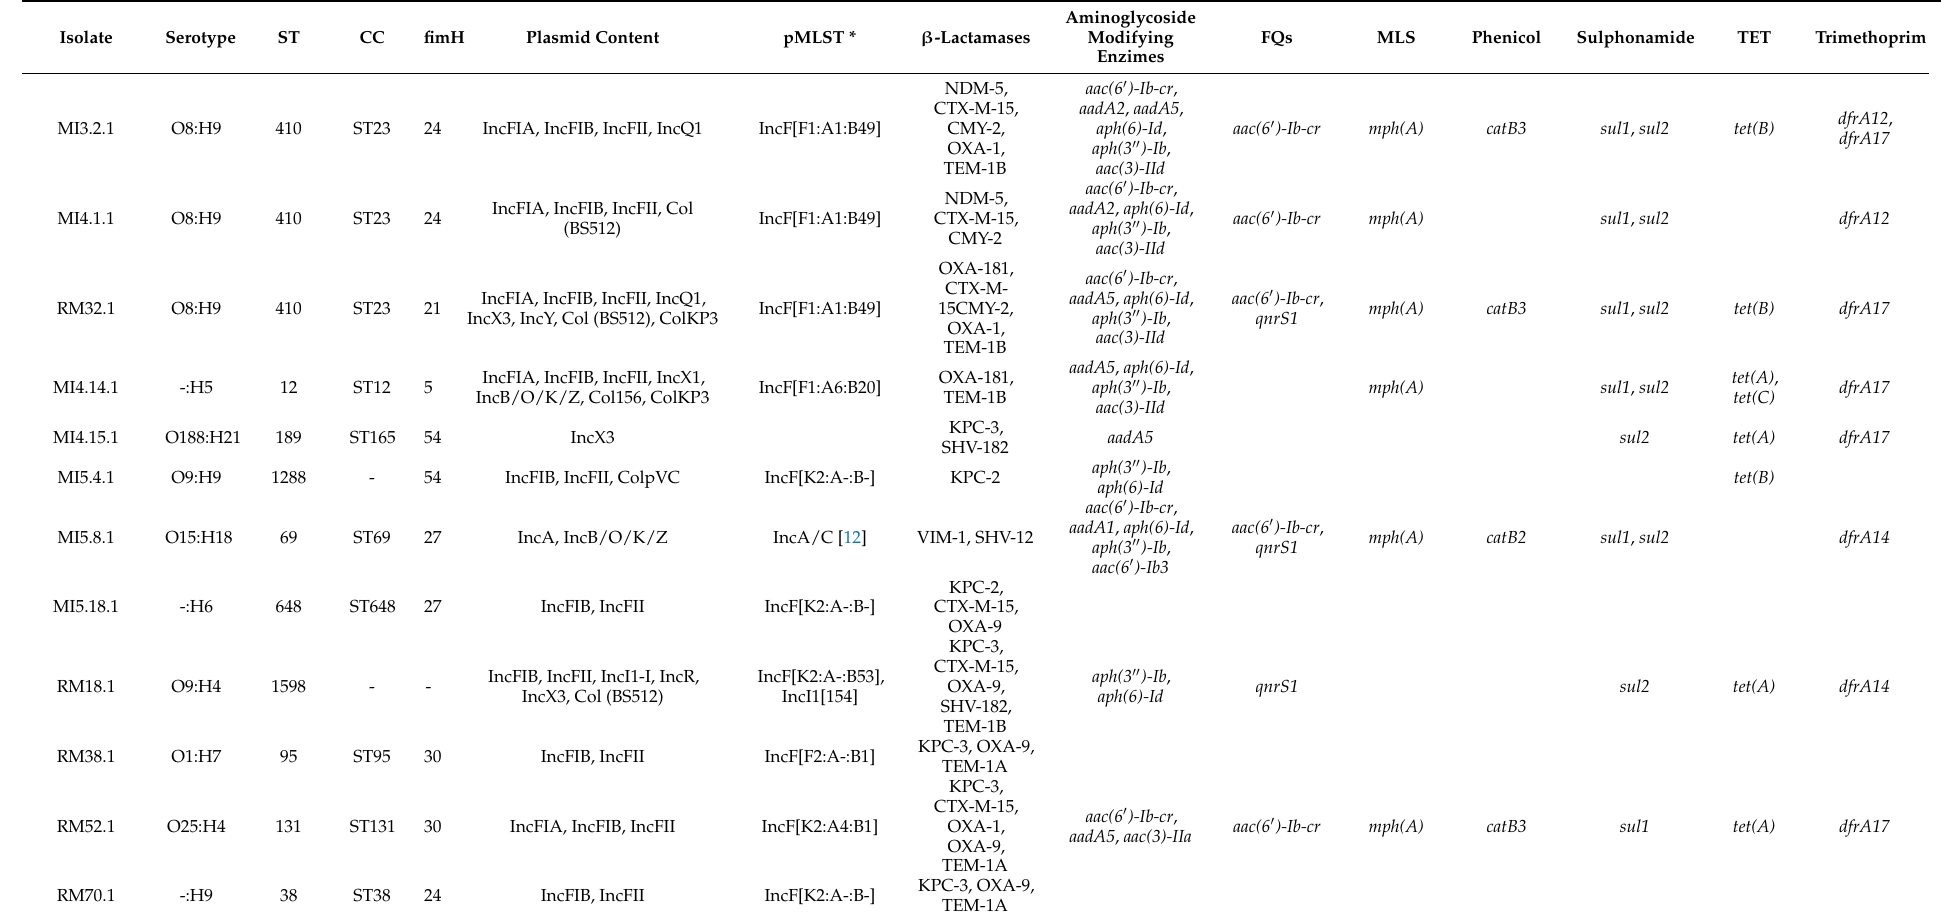
Table 1. Molecular and resistome analysis of 12 CP- Escherichia coli isolates from carriage in elderly